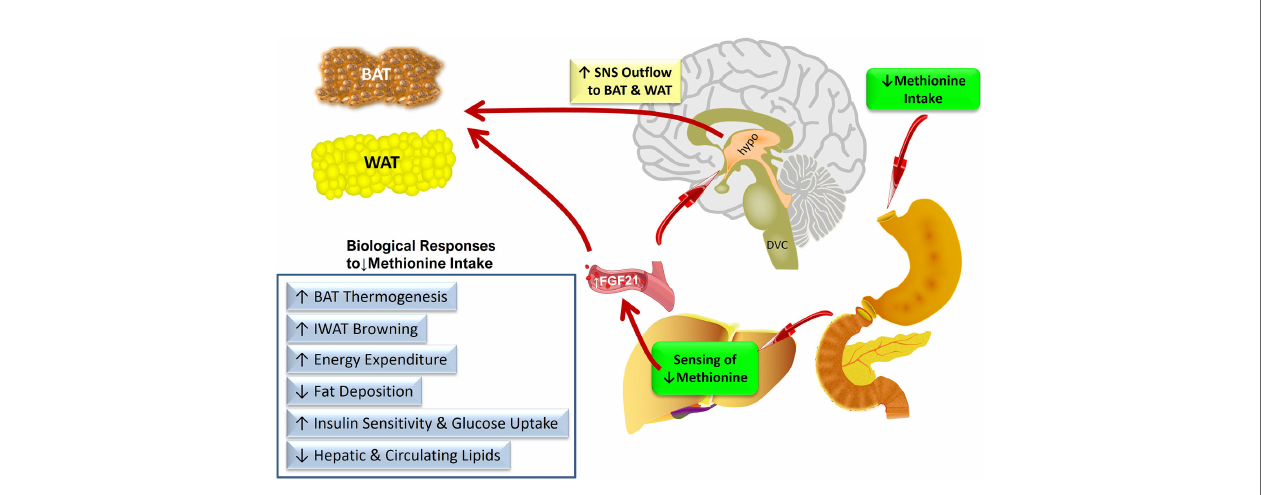
FIGURE 1 | Conceptual model of the anatomical organization of the sensing and signaling systems that link increased transcription and release of FGF21 from the liver to the metabolic responses produced by dietary methionine restriction. Abbreviations used – BAT, brown adipose tissue; IWAT, inguinal white adipose tissue; SNS, sympathetic nervous system; DVC, dorso-vagal complex; hypo,